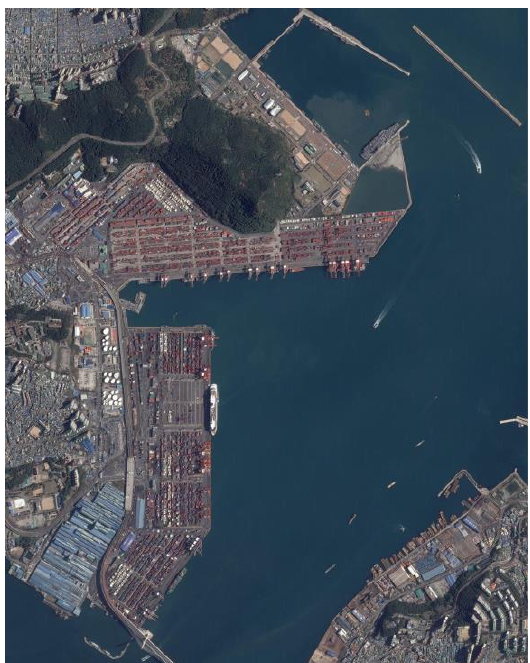
Figure 2. Busan Port in Republic of Korea